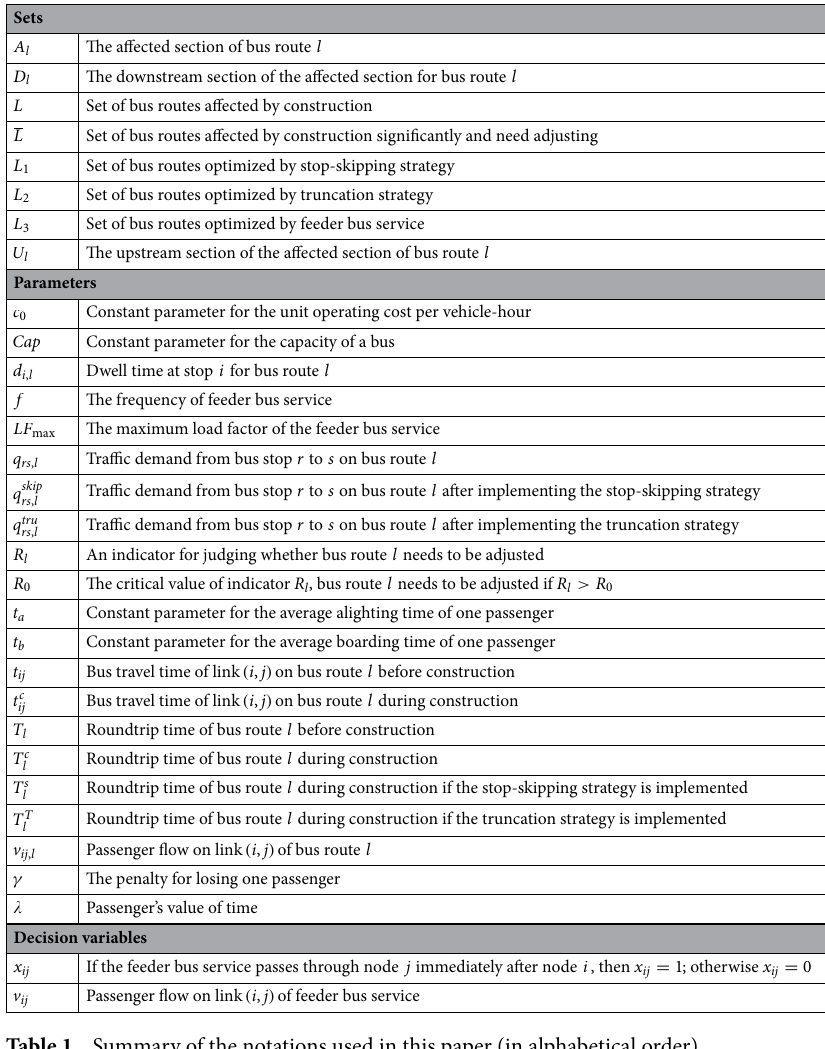
suit. Let L represent the set of bus routes affected by construction. Hereinafter, the affected bus routes refer to bus routes partially collinear with the road sections under construction. For ease of presentation, the notations for parameters and variables used in this paper are summarized in Table 1. A three-step adjustment framework is proposed to actively mitigate the impact of rail transit construction on bus operations and its flowchart is shown in Fig. 1. Each bus route is affected by construction to a different degree. In Step I, an indicator is first proposed to evaluate whether the bus route is significantly affected due to rail transit construction and needs to be adjusted. The set of bus routes that need to be adjusted is denoted by L . In Step II, we design two strategies, i.e., the stop-skipping strategy and truncation strategy, and check whether they are opportune to ameliorate the service of each bus route in L . Every bus route is divided into three sec- tions, including the affected section (collinear with rail transit line under construction) and its upstream and downstream sections, which are denoted by A l , U l , and D l , respectively. In Fig. 2a, the affected section, and its upstream and downstream sections of bus route 1 are A 1 = { 4, 5 } , U 1 = { 1, 2, 3 } , and D 1 = { 6, 7, 8 } , respectively. The stop-skipping strategy in this paper refers to skipping the bus stops in the affected section, for example, bus stops 4 and 5 are skipped in Fig. 2a. The truncation strategy refers to skipping the bus stops and sections both in the affected section and the downstream section. In Fig. 2b, the bus route skips bus stops 7 and 8, as well as bus sections between stop 6 and stop 8. Then the terminal stop of the route changes from stop 8 to stop 6. These two strategies may reduce operating costs, as well as some passengers’ travel costs because they experi- ence a shorter travel time. Yet, the two strategies may result in a loss of ridership since some stops are not served. Passengers who start or end at these stops will not be able to ride. Assume the penalty for losing one passenger is γ . The sum of operating costs and passenger travel costs before and after the implementation of the strategies are calculated to determine whether taking the strategy, i.e., if a strategy can reduce the cost of one bus route, then it is implemented to adjust the bus route. Specifically, if a bus route meets the criteria of the stop-skipping and